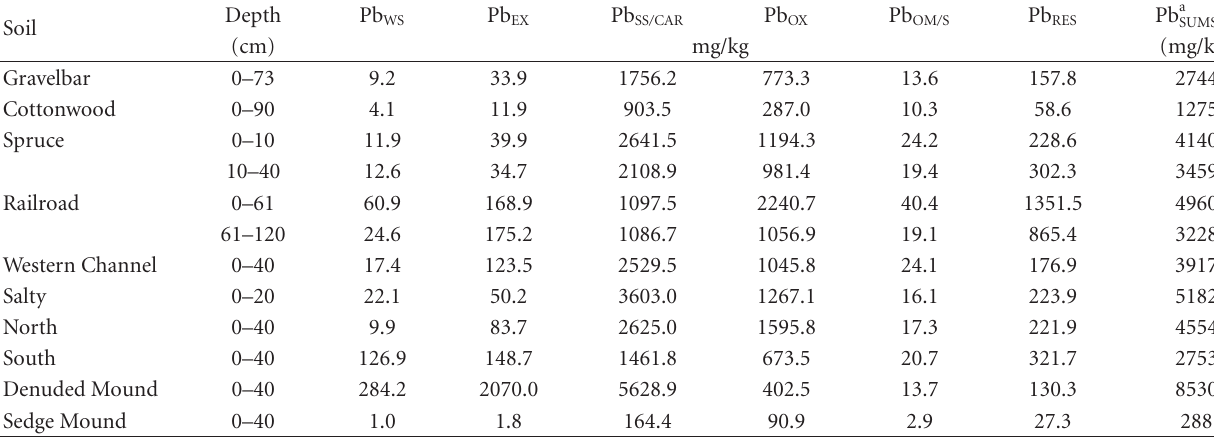
Table 10: Sequential fractionation of Pb in study